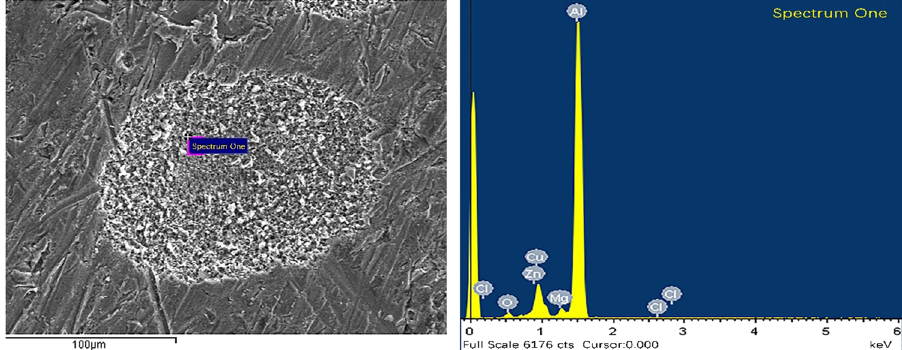
Figure 15: EDS analysis of chloride corrosion area of the aluminium